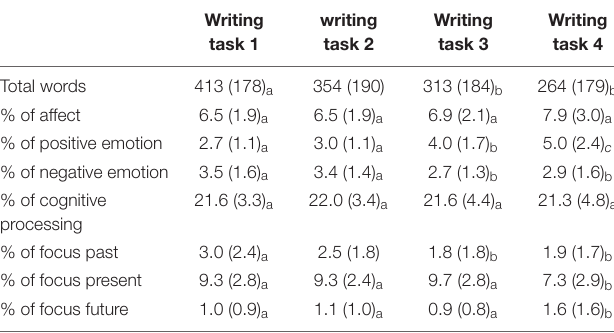
Values for the experimental group (n = 85) are reported as M (SD). Means in the same rows with different subscripts differ at the p = 0.01 level by Bonferroni pairwise comparisons. Means with the same or no subscript do not significantly